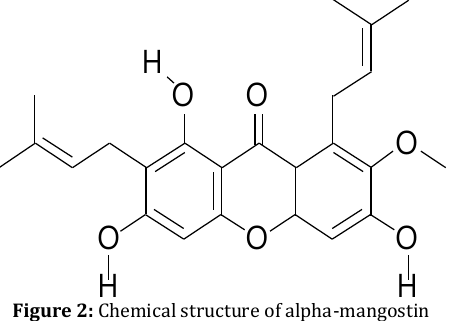
Figure 2: Chemical structure of alpha-mangostin